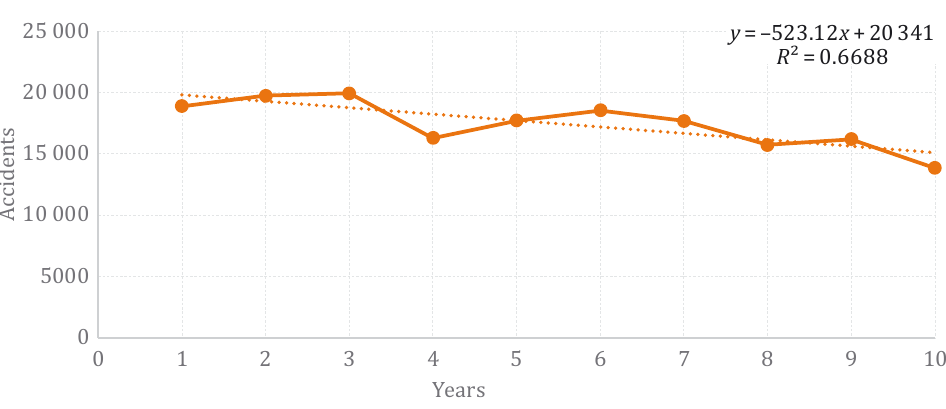
Figure 4. Number of accidents for the period of 2011–2020 associated with a linear trend